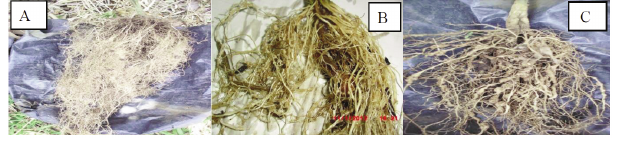
Fig. 3 ­ The effect of Lippia and Ocimum on the tomato root system. A) LK+ OG at 800 g show fibrous root system, B) LK+OG at 200 g with fewer galls, and C) Non­amended soil high nematodes infestation.